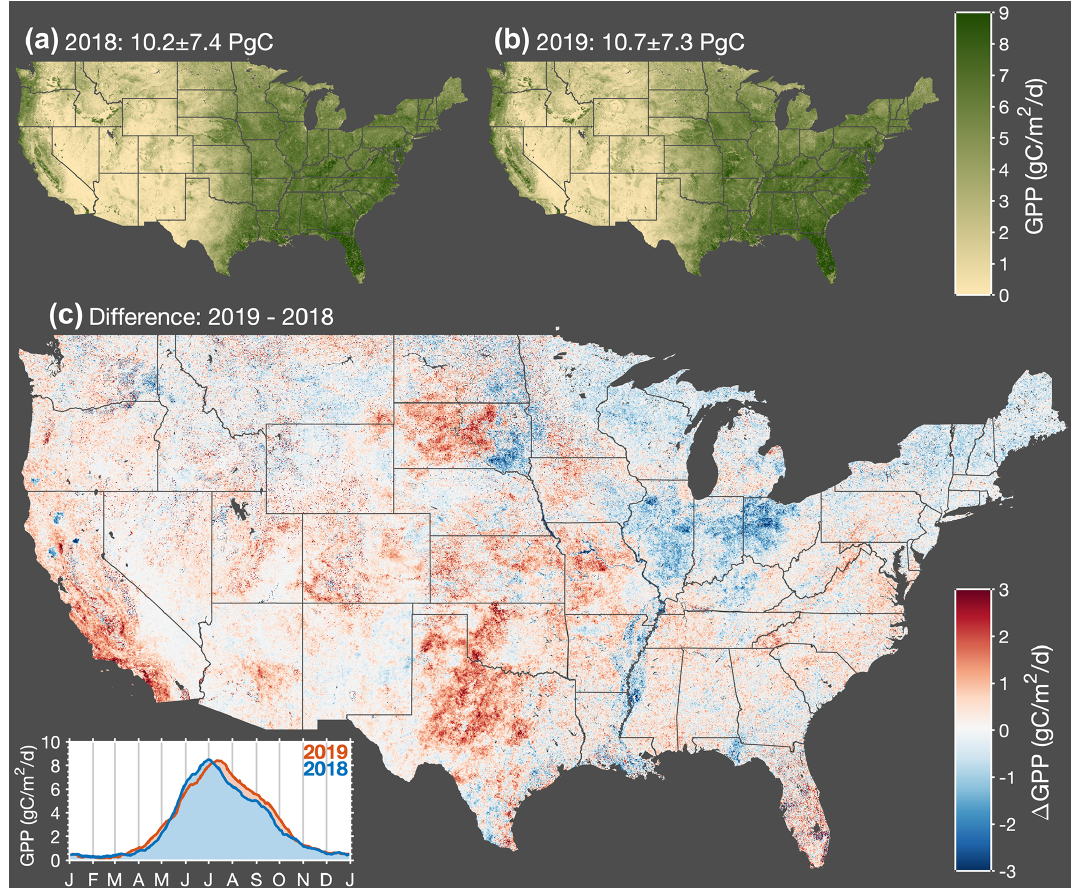
Figure 3. Interannual variations in gross primary productivity across CONUS. Map of annual mean GPP for 2018 (a) and 2019 (b) . (c) Map of the difference in annual mean GPP between 2019 and 2018. Red indicates higher GPP in 2019, and blue indicates higher GPP in 2018. Inset in the bottom left corner shows a time series of the average GPP across CONUS for 2018 and